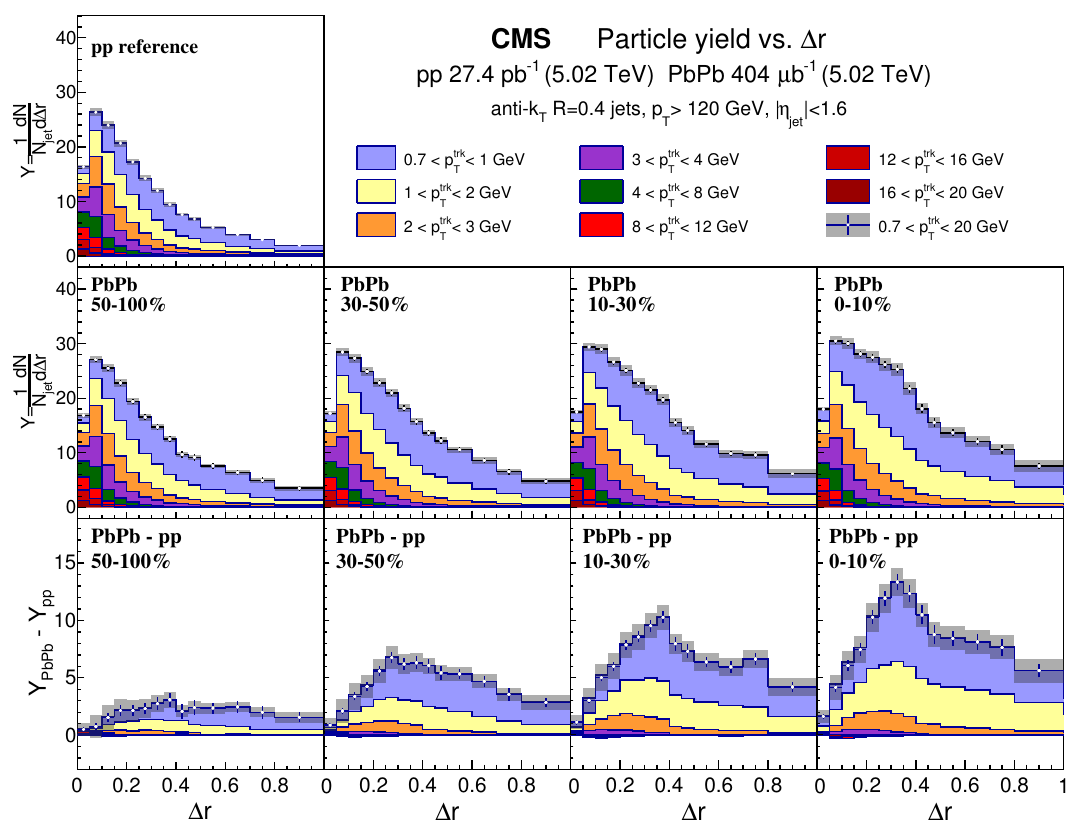
Figure 3 . The distribution of jet-correlated charged-particle tracks as a function of (cid:1)r in pp (top left) and PbPb (middle row) collisions. The PbPb results are shown for di(cid:11)erent centrality regions. The bottom row shows the di(cid:11)erence between the PbPb and pp data. The intervals in p trk indicated by the stacked histograms. The inclusive points (0 : 7 < p trk white circles. The grey bands surrounding these points show the total systematic